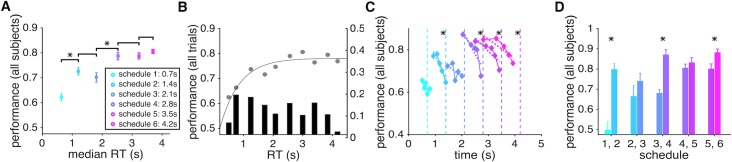
Performance of sensory integration over time is reduced by possible leak in integration and with greater time pressure.(A) Average speed-accuracy tradeoff across subjects. The average performance (probability of a correct response) is plotted as a function of the average median response time (RT) across all subjects, separately for trials with a given level of time pressure. Schedule 1 to 6 correspond to trials with a deadline at 0.7s, 1.4s, 2.1s, 2.8s, 3.5s, and 4.2s, respectively. Averages for different schedules are color coded similarly in all panels. An asterisk above a line indicates that the difference between the performance values for the corresponding schedules was significant (two-sided sign test, p < 0.05). (B) Performance is plotted as a function of RT binned in ten equal intervals across all subjects. Performance increased with longer RT but plateaued at ~2.25s, indicating the leak in integration of sensory information over time. Note that revealed dots stayed on the screen for 2.0s. The solid curve shows the fit using a modified Weibull function (Eq 4 in Materials and Methods). The histogram shows the distribution of RT across the ten bins. (C) Performance reduced as the deadline approached. For each level of time pressure, we divided RTs into five bins and computed the probability of a correct response for trials in a given bin. The dashed lines indicate deadlines, and the asterisk next to each line indicates that performance for the corresponding schedule was significantly worse for longer RT (significant regression slope; two-sided t-test, p < 0.05). (D) Even with equal integration time, performance was worse under greater time pressure. Plotted is the average performance on RT-matched trials (based on mean) with adjacent levels of time pressure. The asterisk above each pair of histograms indicates that the difference between the performance values for the corresponding schedules was significant (two-sided sign test, p < 0.05).